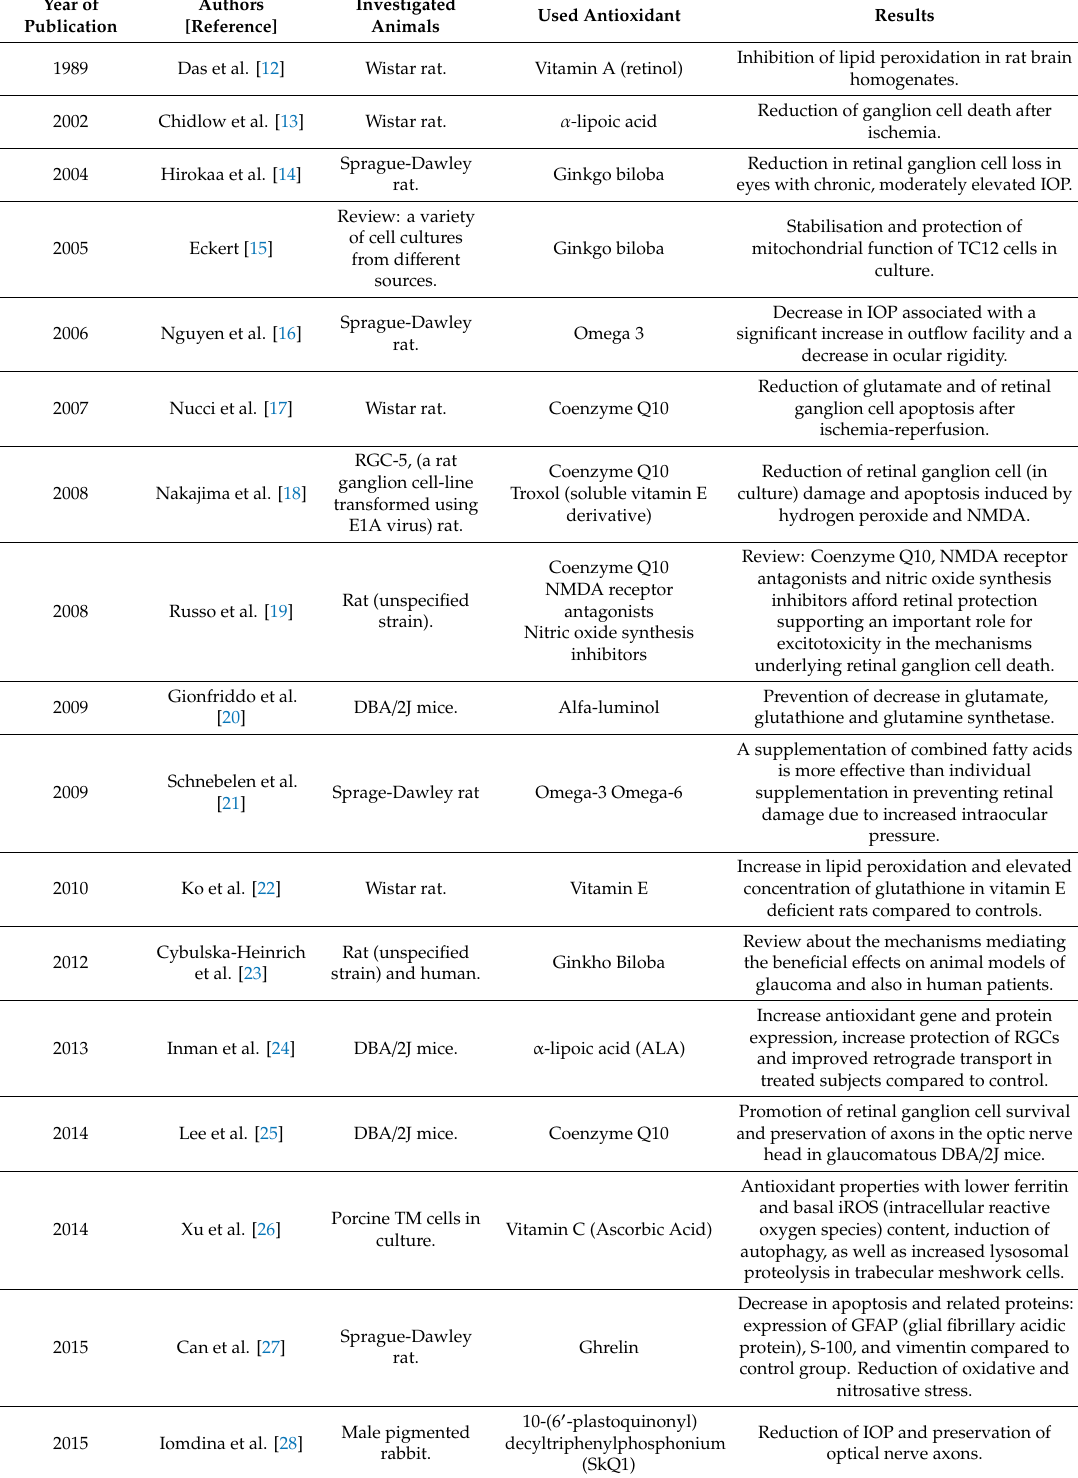
Table 1. Summary of antioxidant supplementation in animal studies (chronological